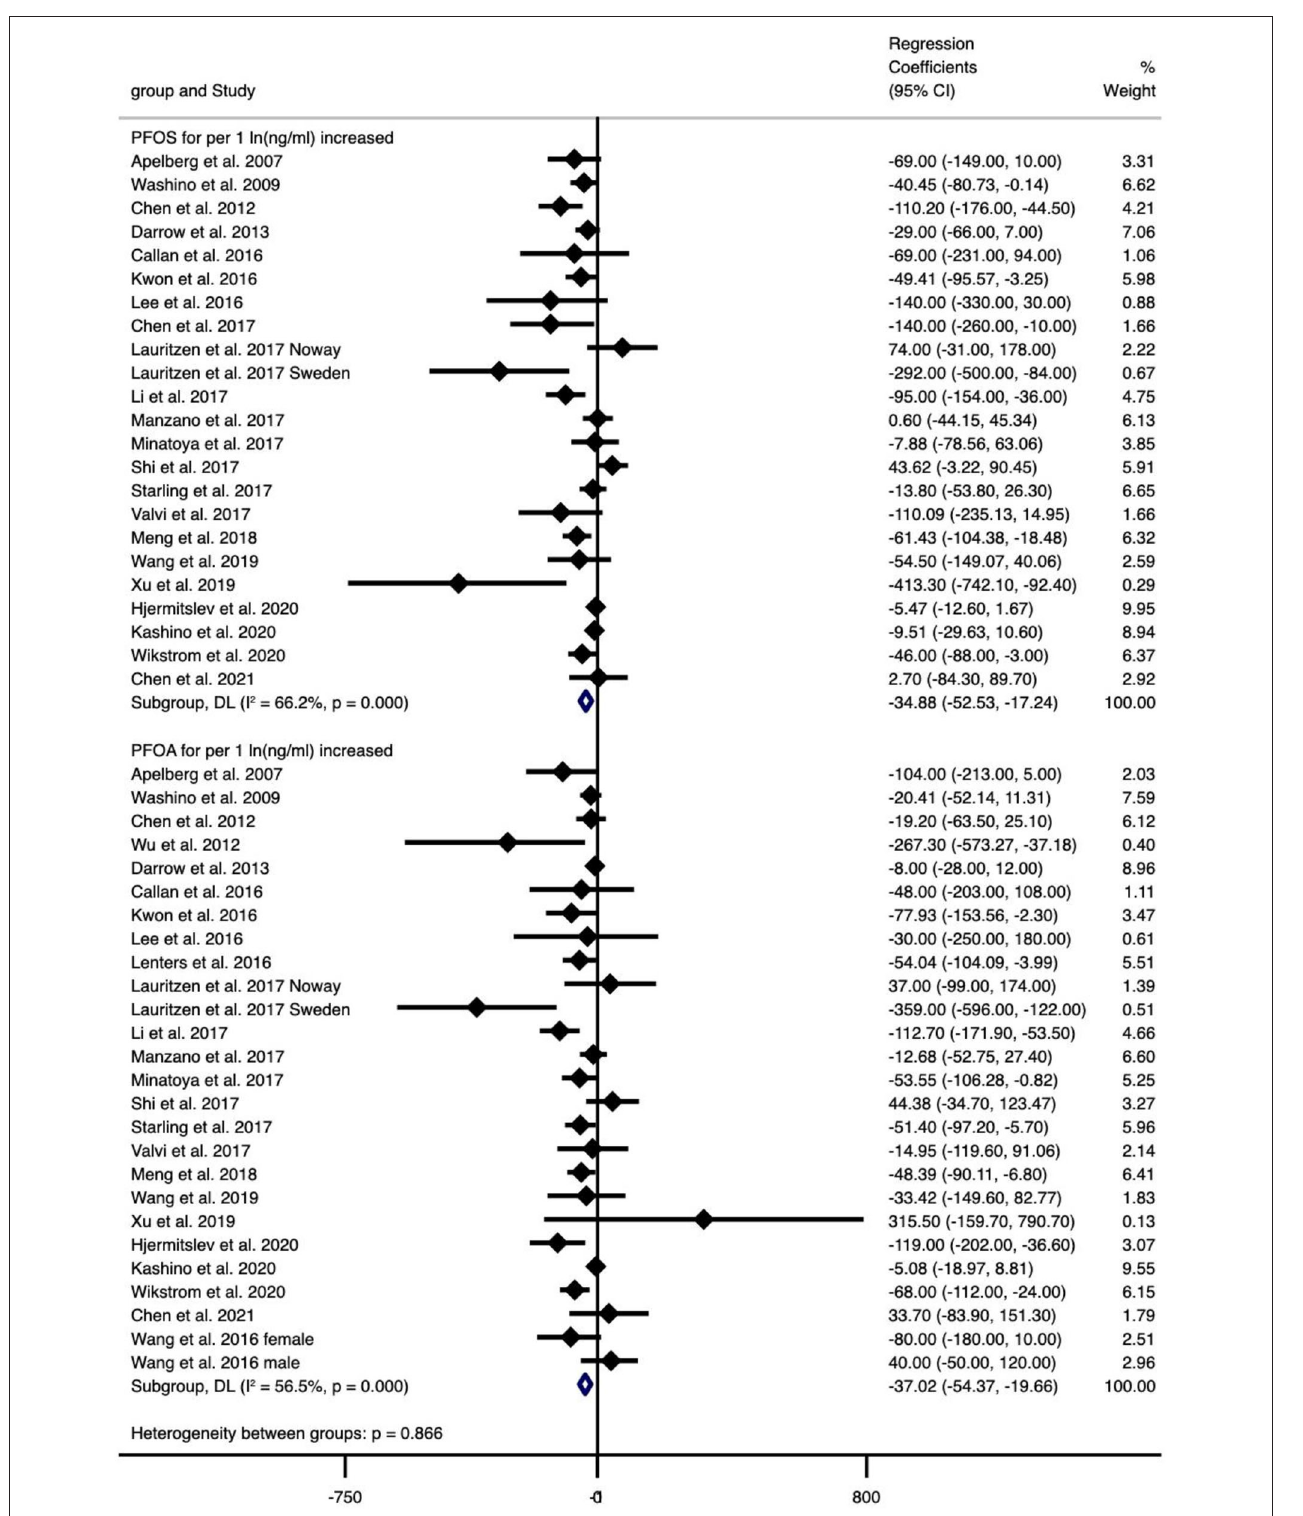
FIGURE 2 | Meta-analysis of the associations of PFOS and PFOA with birth weight (g) for per 1 ln(ng/ml) increment of exposure.